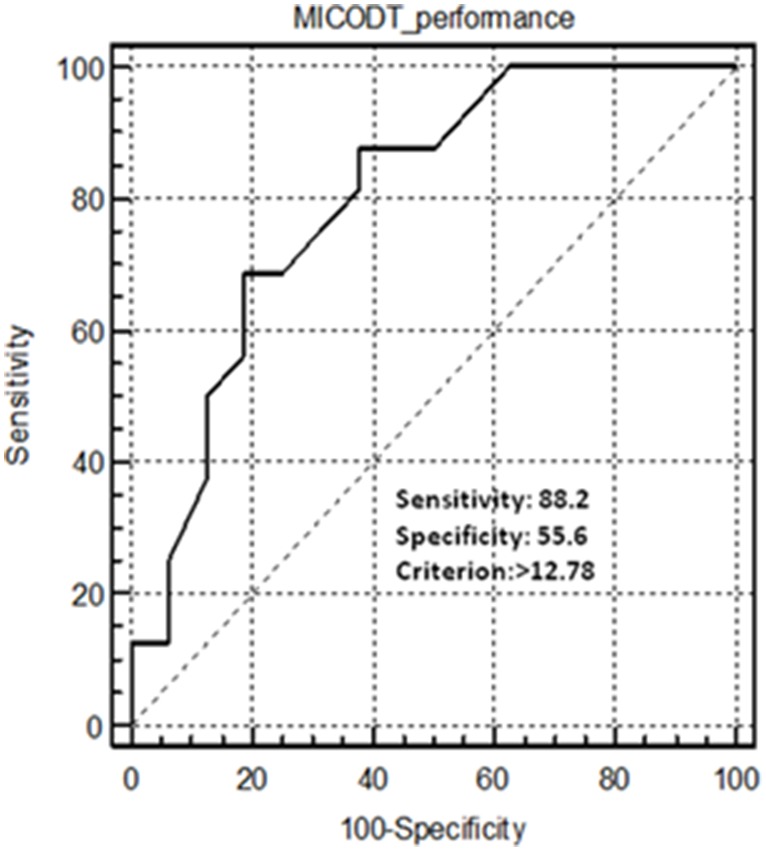
Receiver operating characteristics (ROC) curve for the MICODT between elite and sub-elite U-14 soccer players.